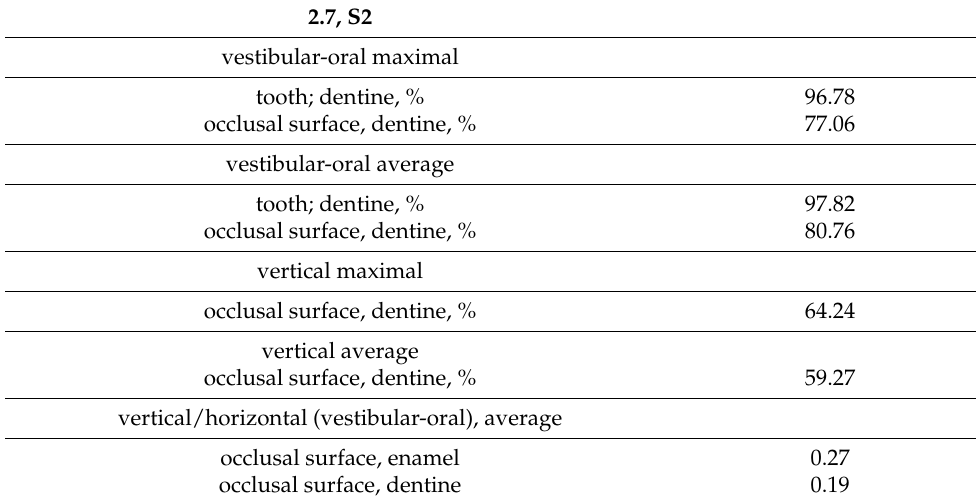
Table 2. Proportions of dentine and enamel parameters, upper left second molar,